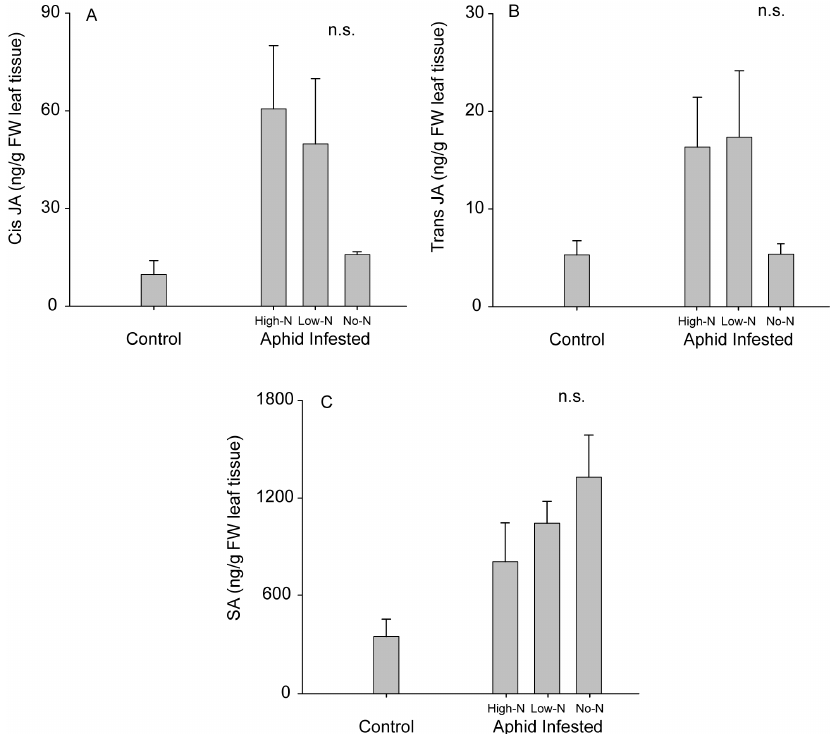
Figure 4. Phytohormone accumulation in undamaged (control) and aphid-infested soybean with varying dependence on rhizobial N: ( A ) cis JA; ( B ) trans JA; ( C ) SA. High-N = High N fertilizer treatment, Low-N = Low N fertilizer treatment, and No-N = no fertilizer. n.s. indicates no significant difference. Results shown as means ±